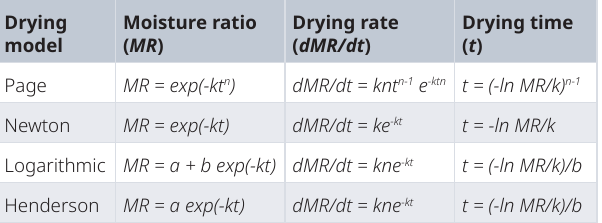
Table 2. Expressions for modelling MR, drying rate and drying time. Drying Moisture ratio model ( MR )